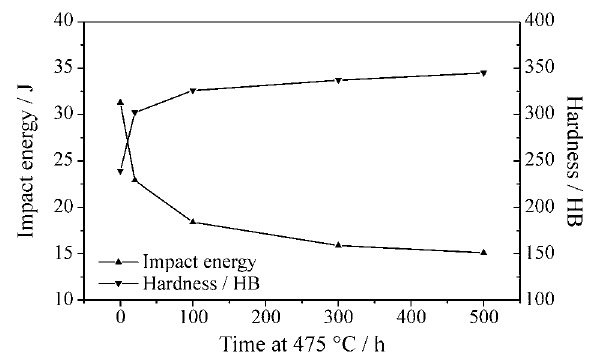
Figure 1. Impact Energy and Brinell Hardness as function of time exposure at 475 °C. (ST = Solution treated).